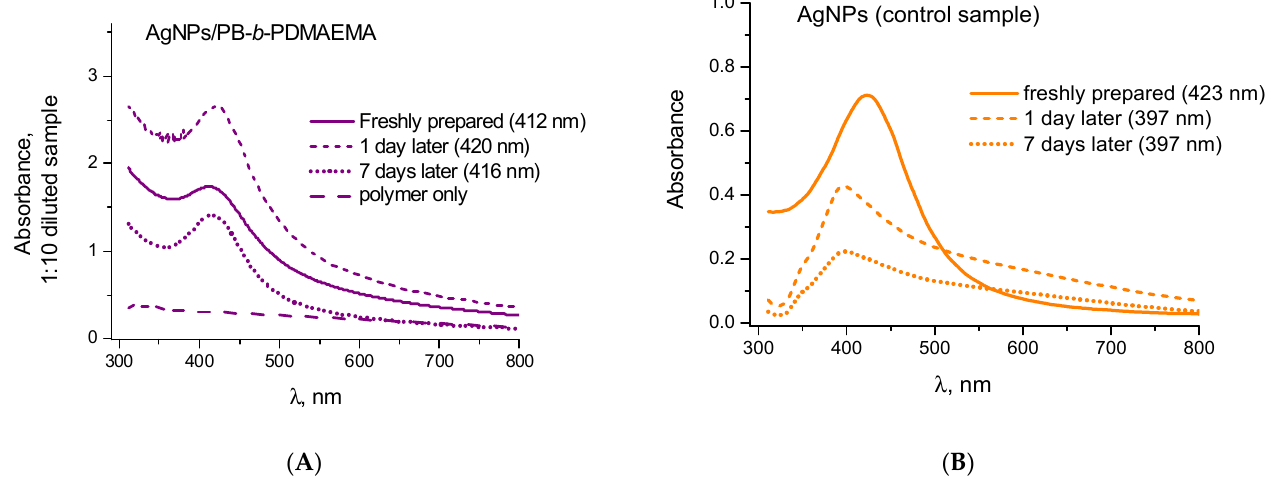
Figure 1. The time evolution of the UV–Vis spectra for the AgNPs prepared ( A ) in the presence and ( B ) in the absence of the PB- b -PDMAEMA micelles.